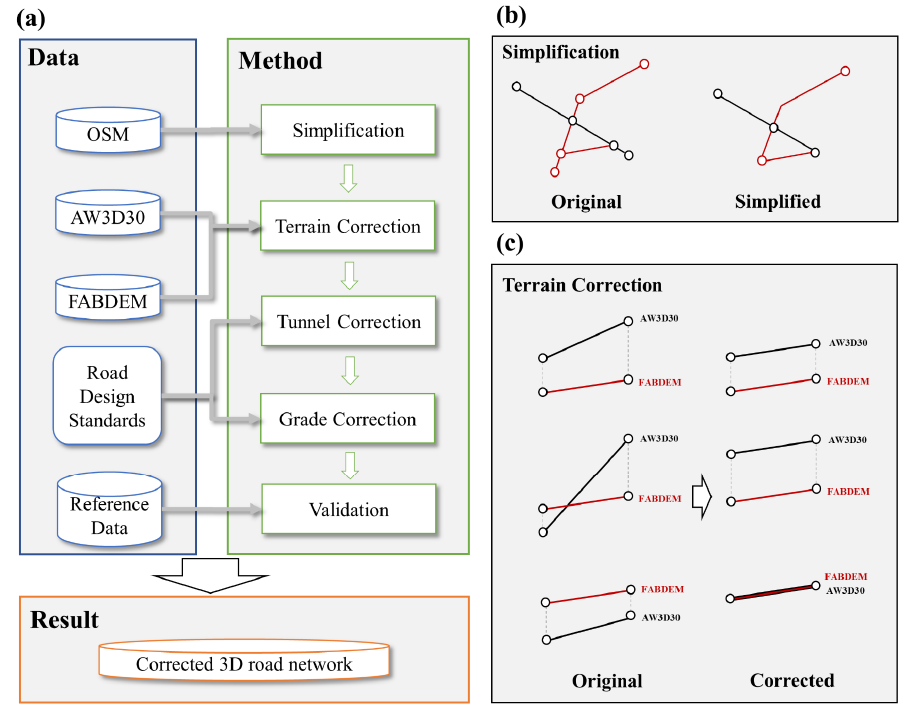
Figure 2. ( a ) Workflow diagram for extracting 3D road networks, ( b ) The detailed process of sim ‐ plification, ( c ) The detailed process for terrain